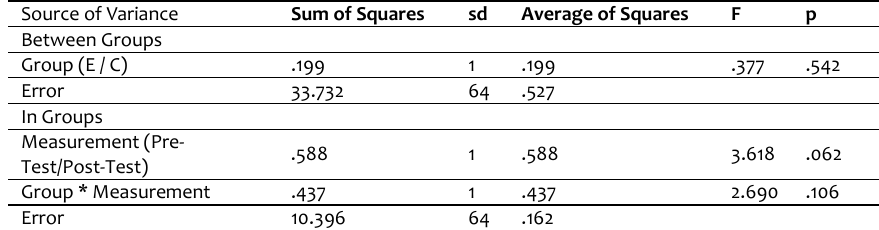
Table 3. Two-Way Analysis of Variance Results for Mixed Measures Source of